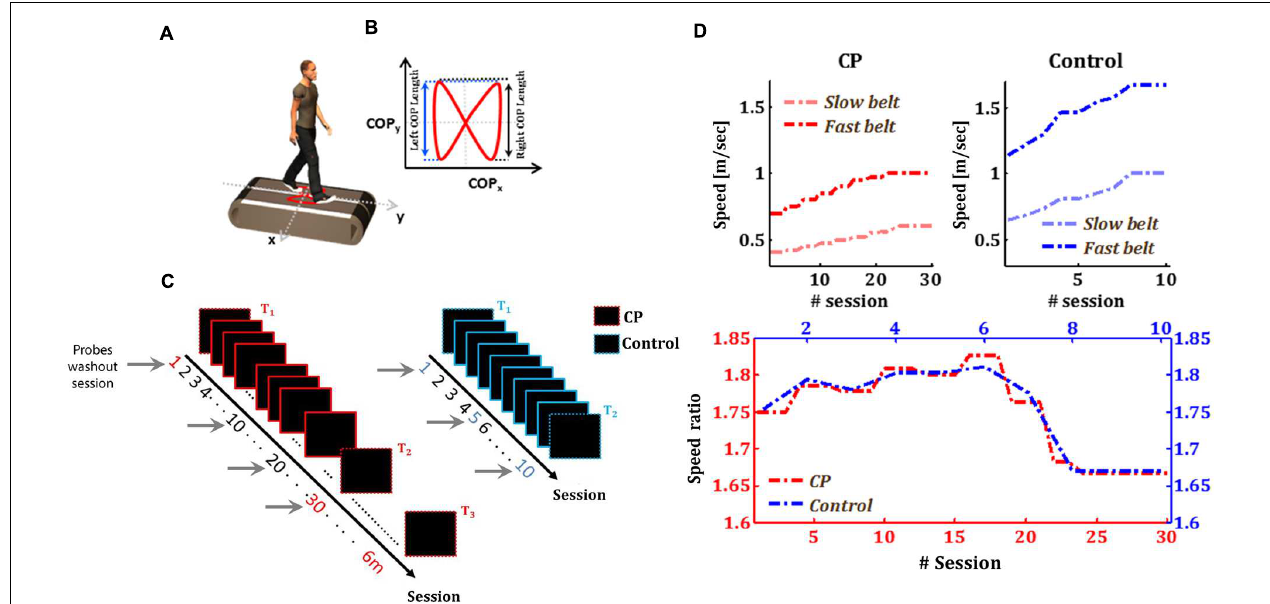
FIGURE 1 | Experimental design and protocols. (A) Subjects walked on a split-belt force treadmill with two separate belts with an embedded force plate (white plate). The red trace represents the center of pressure (COP) profile for one gait cycle. (B) Schematic example for one COP profile for one cycle. (C) Training protocol for CP (red rectangles) and control group (blue rectangles). T 1 and T 2 represent the two test time-points in both groups in which subjects performed the Baseline-Adaptation-Washout paradigm. In the rest of the sessions, subjects were exposed only to the speed perturbation induced by the split-belt treadmill. In T 3 , the CP group did an additional test session, performed 6 months after the end of the adaptation sessions. Gray arrows represent the probes washout sessions. (D) Belt speed in CP and Control groups. Upper left panel: fast (red line) and Slow (light red) belt speeds across sessions in the CP group. Upper right panel: fast (blue line) and Slow (light blue) belt speeds across sessions in the Control group. Bottom panel: speed ratio across sessions in both groups (red and blue curves for CP and Control,